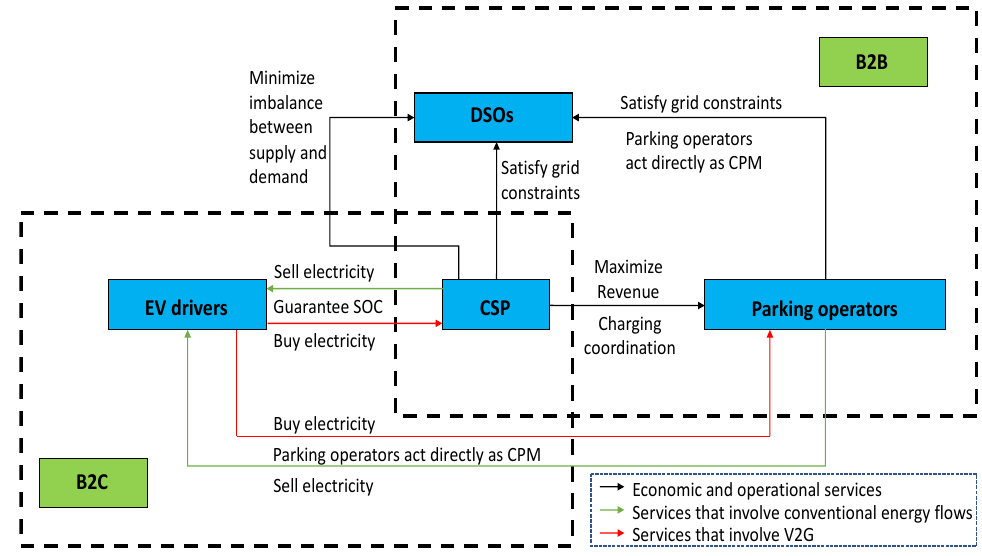
Figure 1. Business-to-Business (B2B) and Business-to-Customer (B2C) services of Charging Service Providers (CSPs) in public and private parking facilities with Vehicle-to-Grid (V2G)-enabled charging infrastructure.